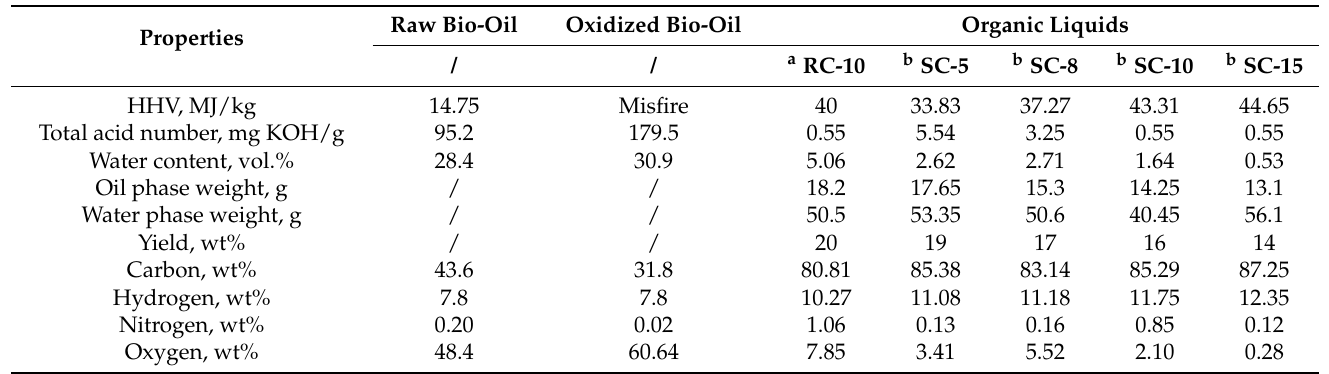
Table 1. Physical properties of raw bio-oil, oxidized bio-oil, and organic